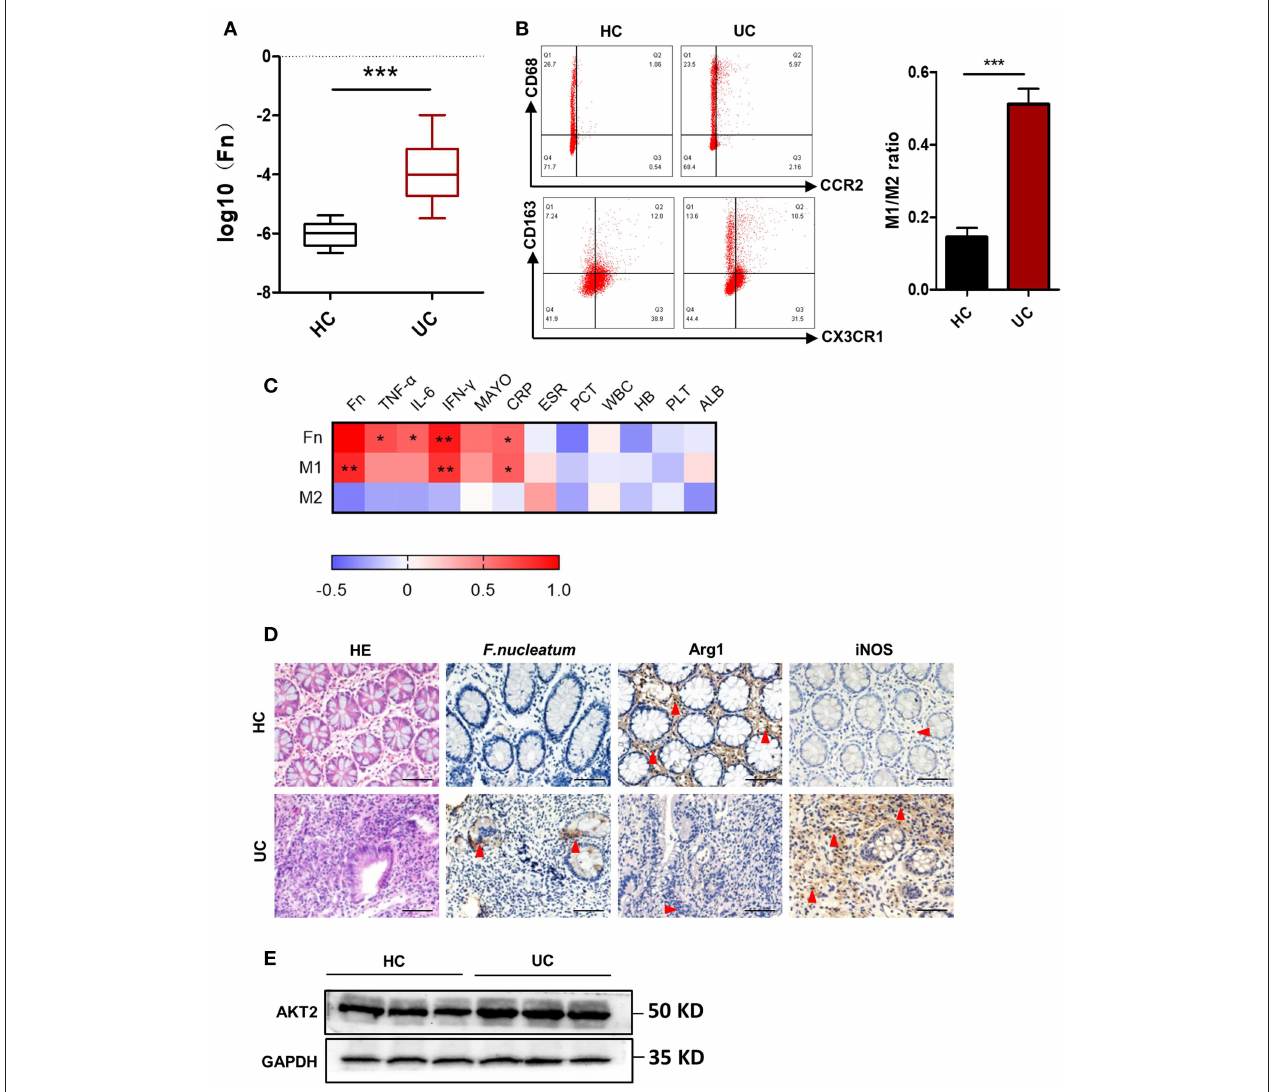
FIGURE 1 | F. nucleatum is present and associated with altered macrophage polarization in UC patients. (A) Absolute fluorescence quantification of fecal F. nucleatum in 30 UC patients and 16 controls. (B) M1 (CD68 + CCR2 + ) and M2 (CD206 + CX3CR1 + ) populations in peripheral blood from those with UC ( n = 12) and controls ( n = 12), as measured by flow cytometry. The difference of M1/M2 ratio between two groups was analyzed. (C) Correlations between F. nucleatum abundance, inflammatory cytokines and clinical parameters from 12 active UC patients. Media values were correlated, with a heatmap of Spearman’s R -values. + indicate the Kendall rank correlation. Black margins denote those correlations that were significant even when analyzing individual samples based on Kendall’s p -values. (D) Hematoxylin and eosin (H&E) and immunochemistry (IHC) staining for F. nucleatum, Arginase 1 (Arg1, M2 specific marker), and inducible nitric oxide synthase (iNOS, M1 specific marker) in sections of colon tissue from UC patients ( n = 12) or healthy controls ( n = 12). Scale bars, 25 µ m. (E) Western blot analysis of AKT2 expression in UC patients ( n = 12) and healthy controls ( n = 12). Data are presented as means ± SD. * P < 0.05; ** P < 0.01; *** P < 0.001; Student’s t -test (two-tailed). CRP, C-reactive protein C; ESR, erythrocyte sedimentation rate; PCT, procalcitonin; WBC, white blood cell; HB, hemoglobin; PLT, platelet; ALB, albumin.